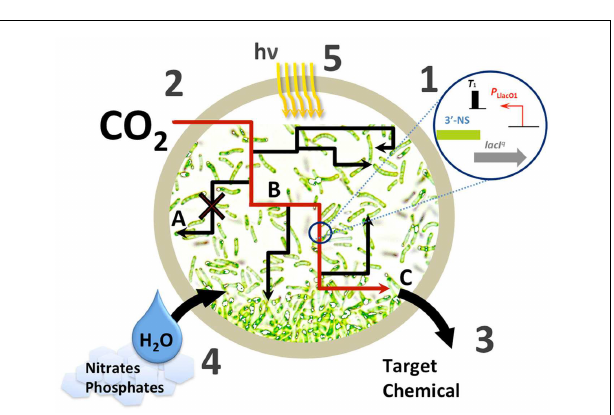
FIGURE 1 | Challenges in cyanobacterial chemical production . (1) Improving available biological parts at each level of the central dogma for engineering artificial pathways in cyanobacteria; (2) improving carbon fixation; (3), improving metabolic yield with various strategies, A – eliminating competing pathways, B – improving pathway flux, for example via irreversible steps, C – improving tolerance to or